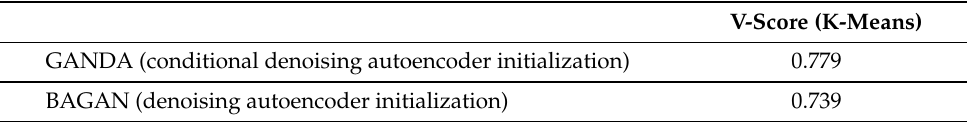
Classification score: Tables 4 and 5 show the effects of using the generated samples as